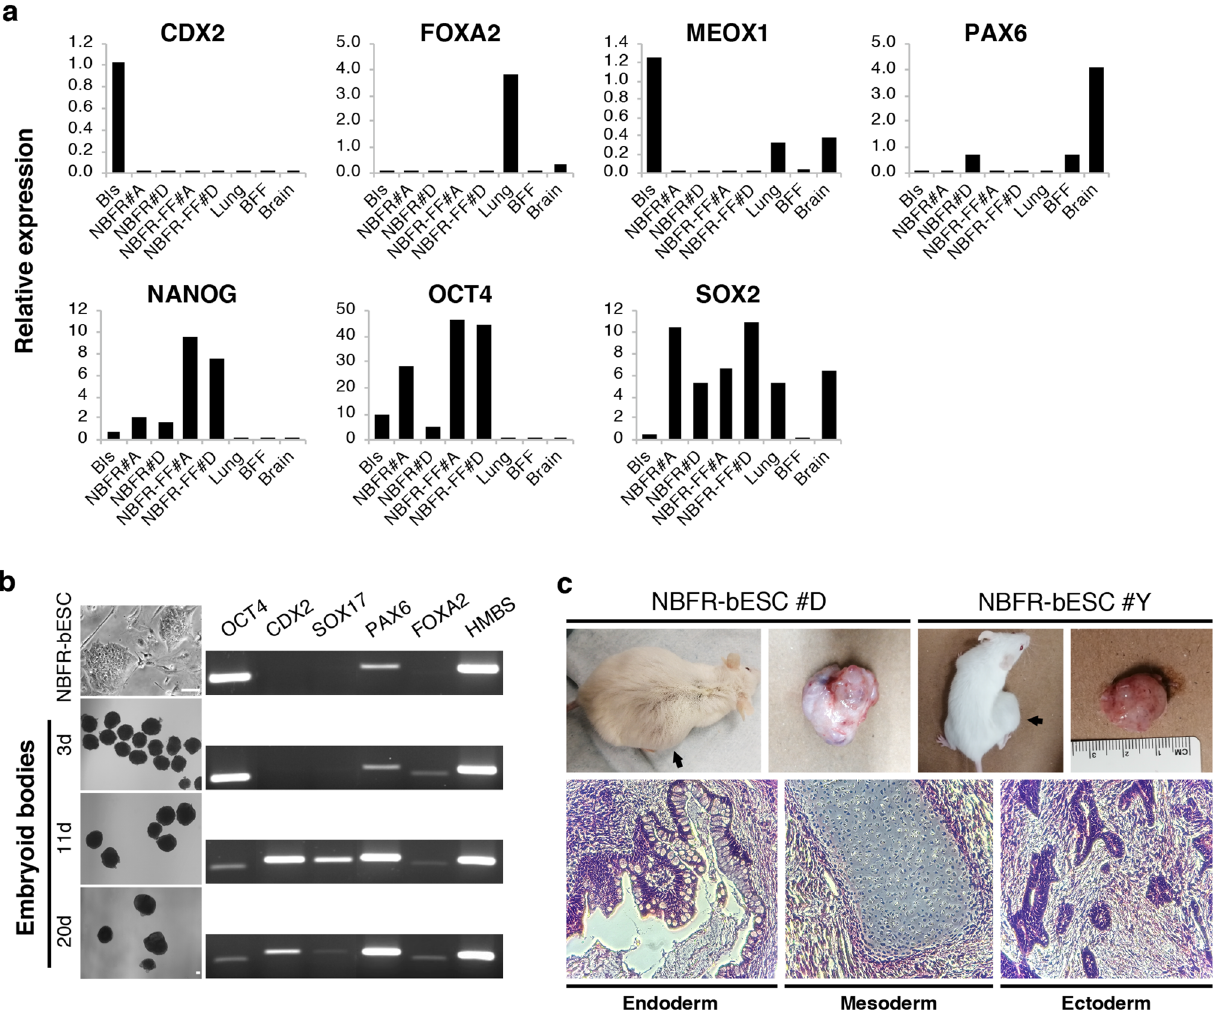
Figure 3. In vitro and in vivo differentiation of NBFR-bESCs. ( a ) Gene expression levels of pluripotency ( OCT4 , SOX2 , NANOG ), trophectoderm ( CDX2 ), endoderm ( FOXA2 ), ectoderm ( PAX6 ), and mesoderm ( MEOX1 ) markers in representative tissues and two independent NBFR-bESCs lines before (NBFR#A and NBFR#D at passage 10) and after adaptation to feeder-free culture (NBFR-FF #A and #D, passage 10 and 20 after adaptation, respectively). Relative expression was calculated using the comparative CT method (ΔΔCT), normalizing values to HMBS . ( b ) Bright field images of NBFR-bESCs and embryoid bodies obtained at different times of differentiation. RT-PCR for genes representative of different lineages ( OCT4 , CDX2 , SOX17 , PAX6, and FOXA2 ). HMBS : housekeeping gene. Scale bar 100 μm. ( c ) Teratomas obtained 12 weeks after injection of two independent NBFR-bESC lines (NBFR #D and #Y) into immunodeficient mouse. Representative histological images showing derivates of the 3 germ lineages. BFF: bovine fetal fibroblasts; Bls: blastocysts, d: